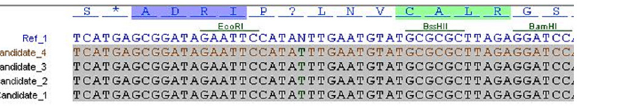
Fig 2. View restriction sites and amino acid motifs. Zoomed view of the middle panel showing the EcoRI, BssHII, and BamHI restriction enzyme sites and the amino acids with the reference frame motif in purple and a second motif shown in green. The ambiguous nucleotide ( “ N ” ) in the reference sequence can be inferred to be a “ T ” based on the consensus amongst the candidates.